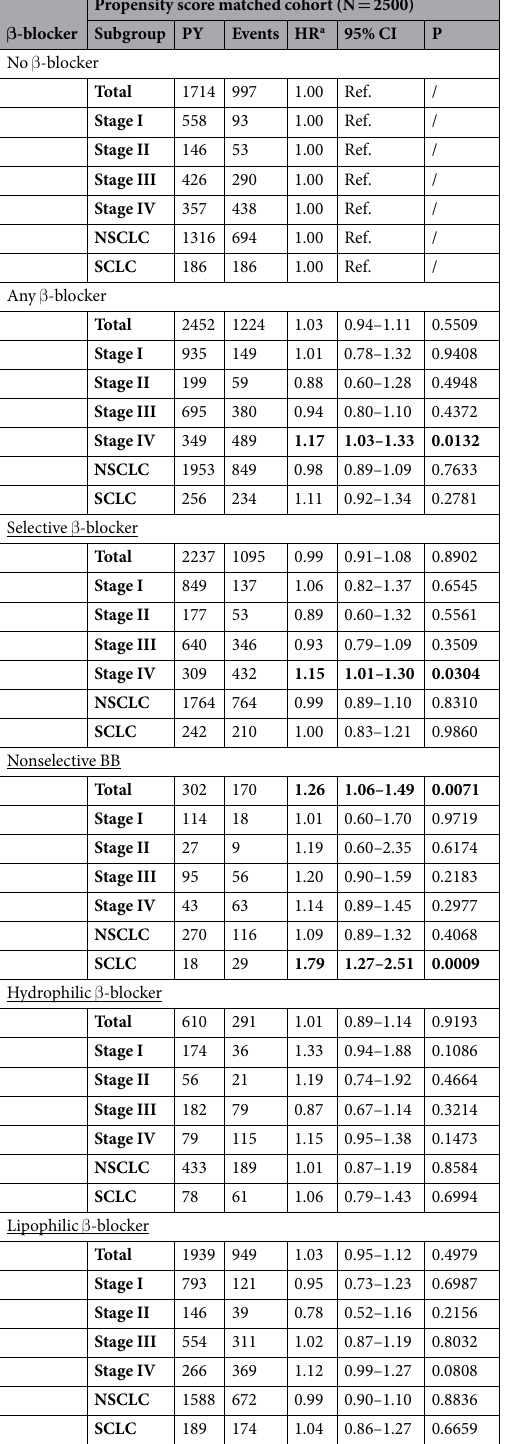
Table 3. Association between Post-diagnostic β -blocker use and Lung Cancer Survival (Overall, by Histological Subtype and Cancer Stage). Abbreviations: ATC = Anatomical Therapeutic Chemical Code, CI = Confidence interval, HR = Hazard ratio, NSCLC = Non-small cell lung cancer, PY = Person-years, SCLC = Small cell lung cancer. a Hazard ratio from Cox proportional hazard regression on the propensity score matched groups for time-dependent β -blocker use after diagnosis with additional adjustment for time-dependent use of Non- steroidal anti-inflammatory drugs, statins, antihypertensive (other than β -blocker) and diabetes medication after diagnosis. Stratification factors were omitted from the stratified